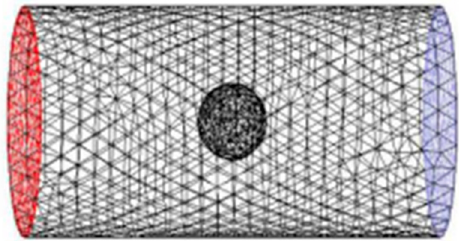
Figure 4. Geometry of the calculation area.